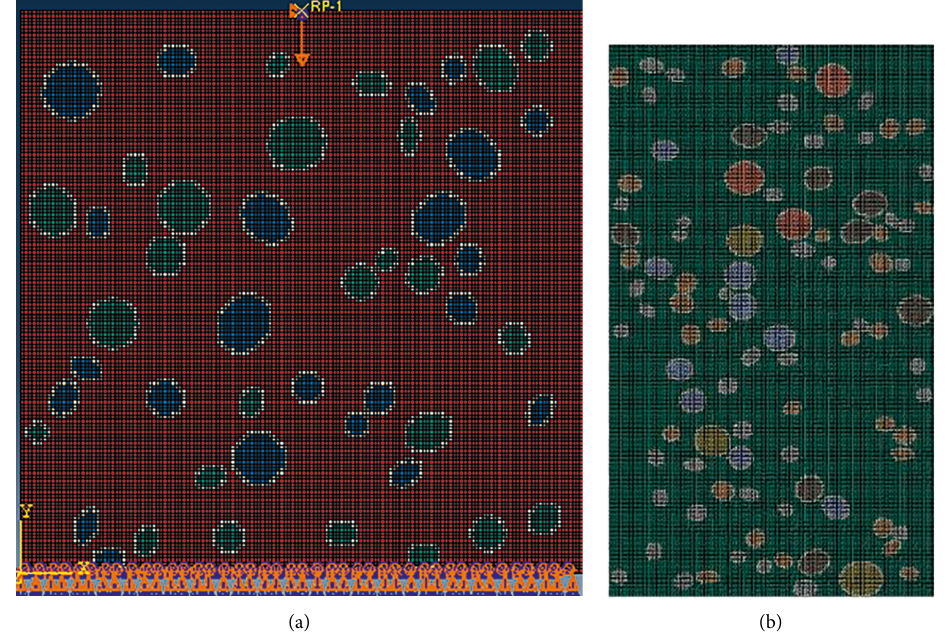
Figure 4: Finite element model. (a) 150mm × 150mm. (b) 150mm × 300mm.